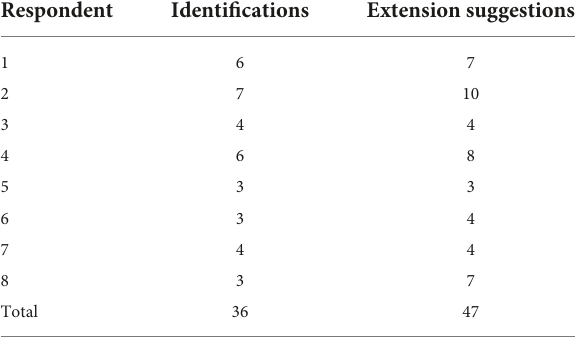
TABLE 7 Respondents identifications and extension suggestions